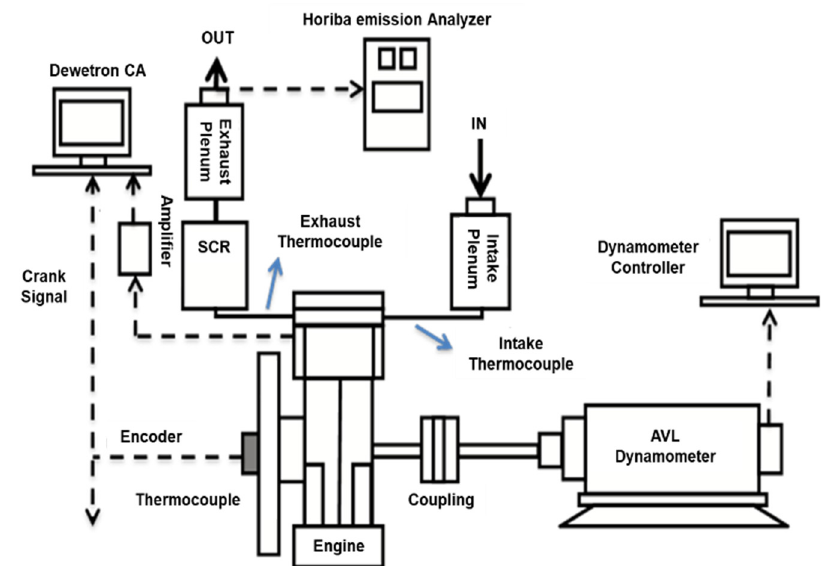
Figure 15. Experimental test and engine measurement setup.